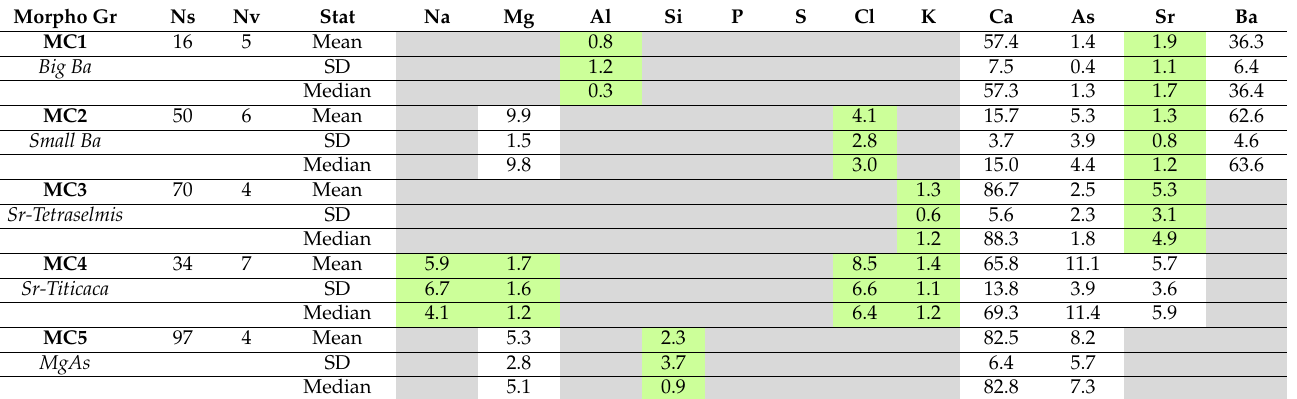
Table 2. Left-censored data: descriptive statistics of characteristic elements in the five morpho-chemical groups of As-containing micropearls in Lake Geneva (MC1, MC2, MC3, and MC5) and Lake Titicaca (MC4). Ns: number of samples. Nv: number of descriptors. SD: standard deviation. Green: ROS- treated. White: lab values (always above detection limit). Grey: not taken into consideration because of a proportion of zero values exceeding 0.7. P and S eliminated because they exceed this criterion in all groups.